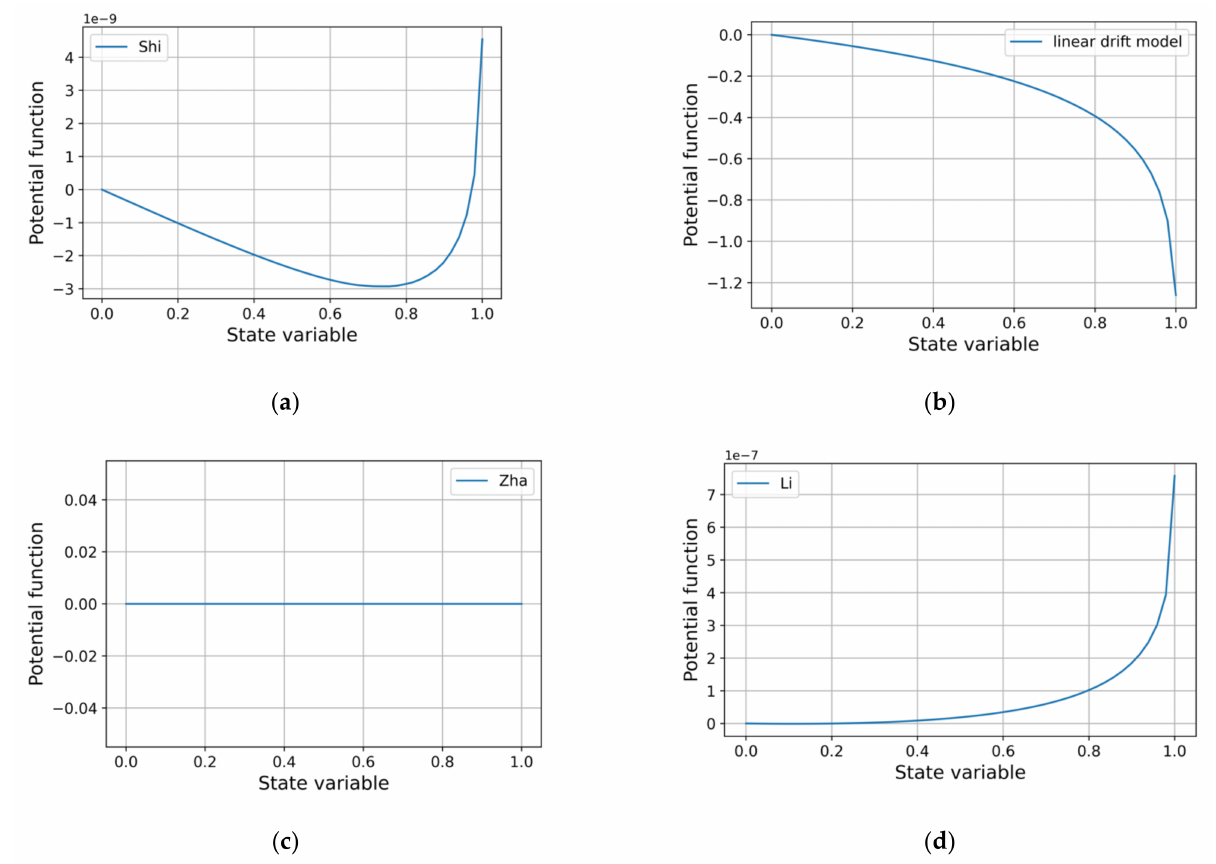
Figure 11. Potential memristor functions of drift models with window functions: ( a ) Shi’s; ( b ) rectangular; ( c ) Zha’s; ( d )